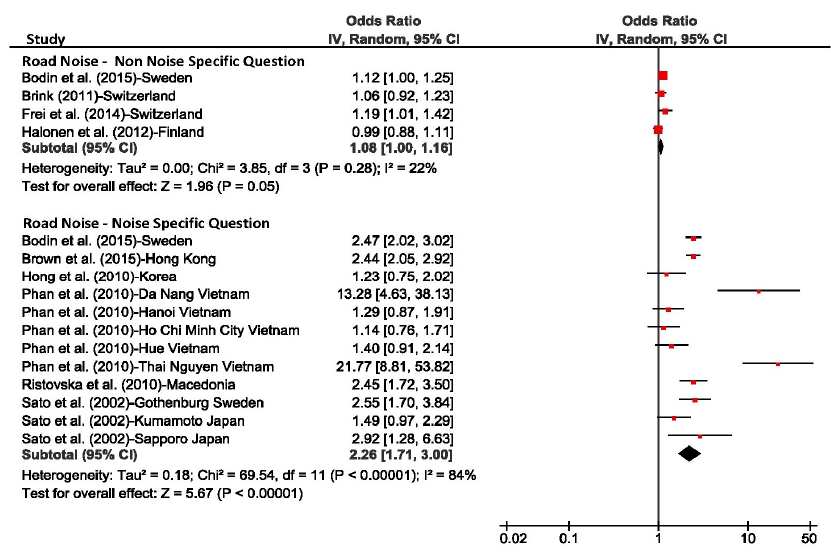
Figure 11. Meta-analysis on the effects of road noise on self-reported sleep disturbance (combined estimate) based on Odds Ratios for a 10 dBA increase in L night level for road noise. The number of studies and subjects contributing to the analyses can be found in Table 3.